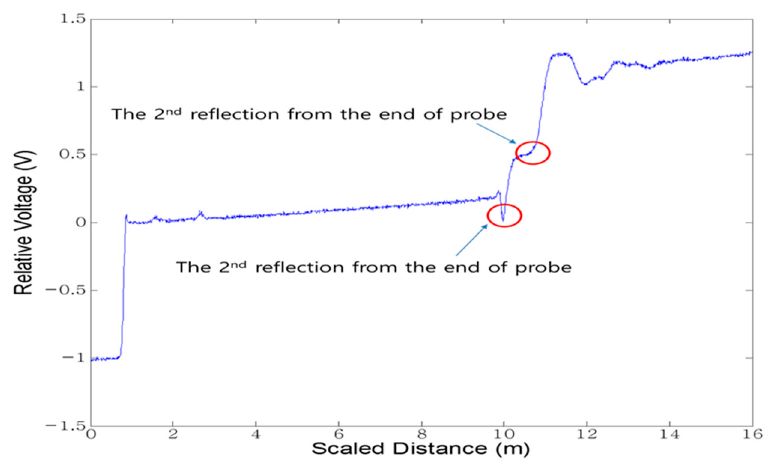
Figure 14. The TDR waveform measured by the flat-type probe.